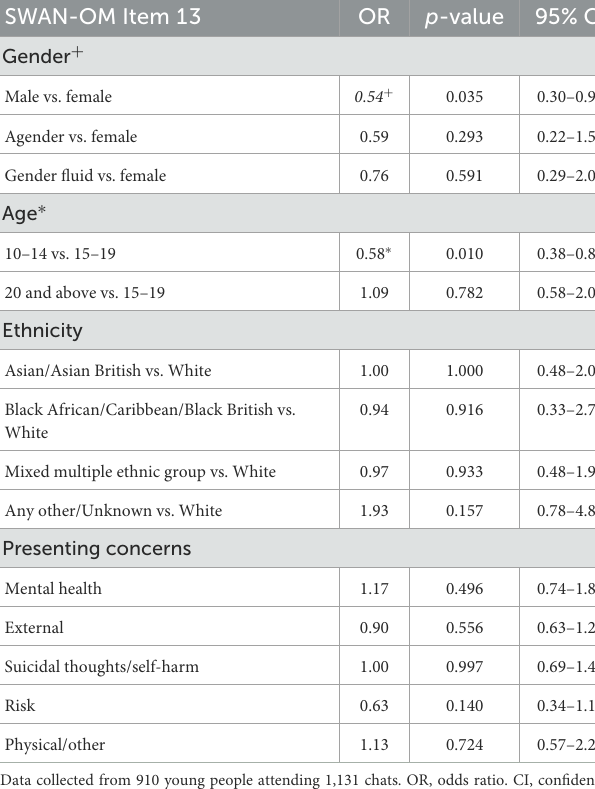
For the rest of the items of the SWAN-OM